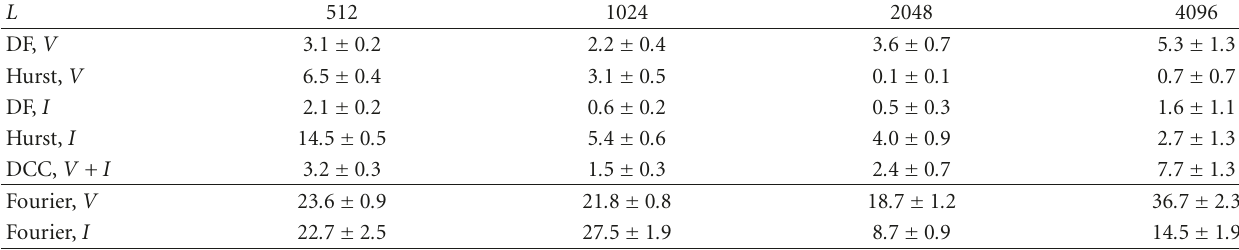
Table 5: Average percentage classification errors of testing voltage ( V ) and current ( I ) signals containing L points, produced by classifiers based on Hurst, detrended-fluctuation (DF), or detrended-cross-correlation (DCC) analyses. Also shown are results for classifiers based on Fourier spectra.